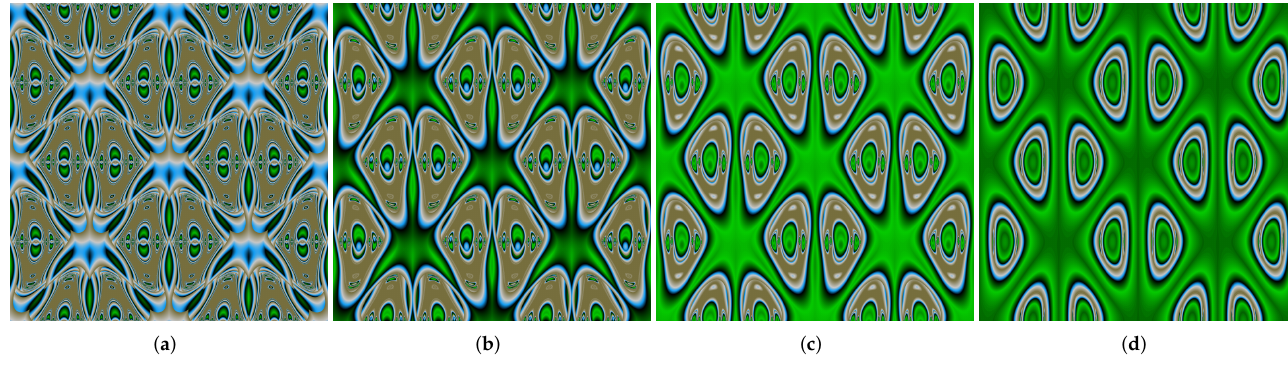
Figure 7. Patterns generated with function f with cmm symmetry and orbit traps from Figure 3a with various values of γ in the Rickman’s rug metric. ( a ) γ = 0.9; ( b ) γ = 0.7; ( c ) γ = 0.5; and ( d ) γ =